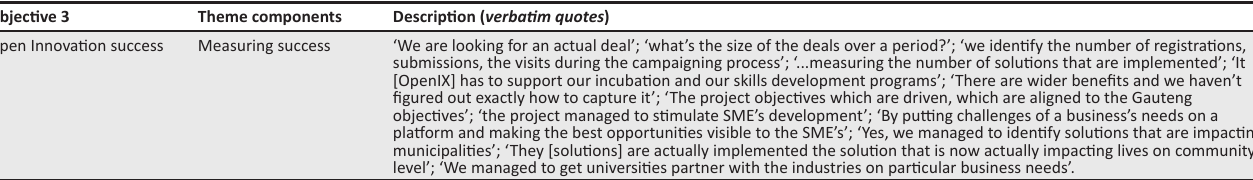
TABLE 3: Direct quotations of responses regarding the key success factors. Objective